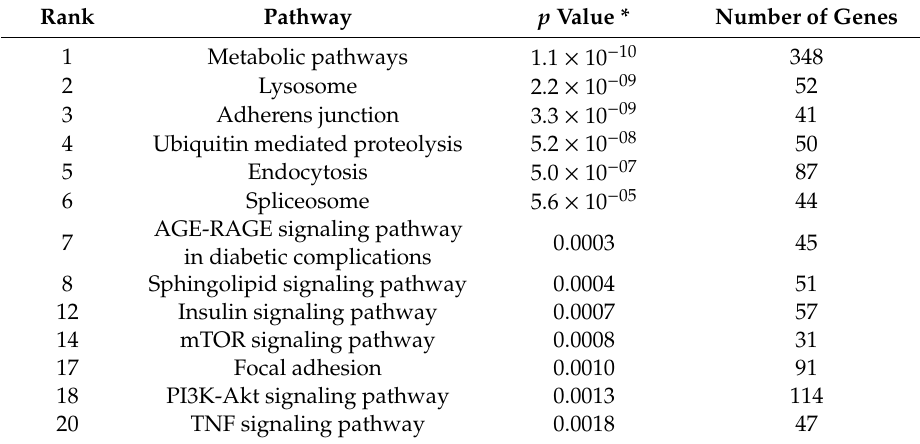
Table 1. C16 ceramide-enriched LDL regulate gene expression of metabolic and signaling pathways in human podocytes.